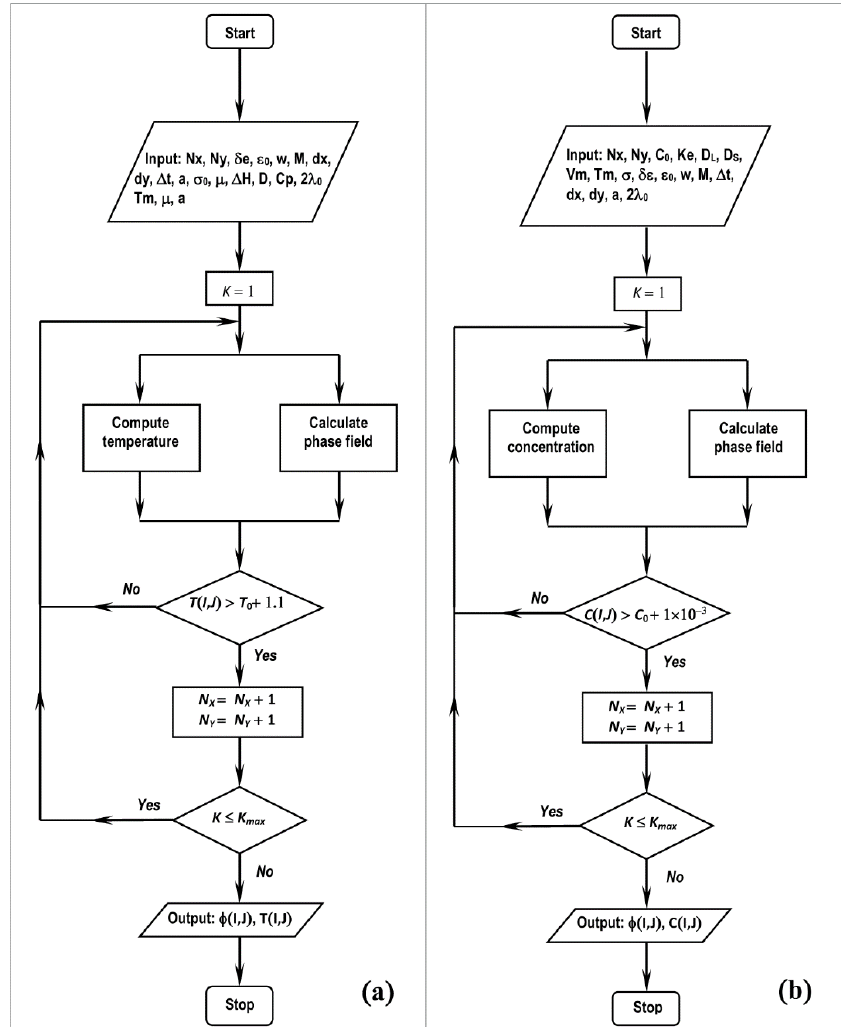
Figure 1. The phase-field model with adaptive computational domain. (a) pure metal and (b) binary